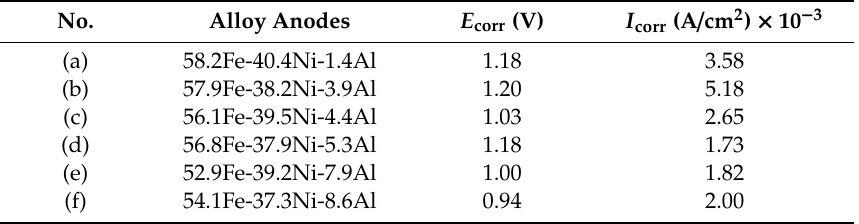
Figure8. Anodicpolarizationcurvesof58.2Fe-40.4Ni-1.4Al( a ),57.9Fe-38.2Ni-3.9Al( b ),56.1Fe-39.5Ni-4.4Al Figure 8. Anodic polarization curves of 58.2Fe-40.4Ni-1.4Al ( a ), 57.9Fe-38.2Ni-3.9Al ( b ), ( c ), 56.8Fe-37.9Ni-5.3Al ( d ), 52.9Fe-39.2Ni-7.9Al ( e ) and 54.1Fe-37.3Ni-8.6Al ( f ) alloys measured in 56.1Fe-39.5Ni-4.4Al ( c ), 56.8Fe-37.9Ni-5.3Al ( d ), 52.9Fe-39.2Ni-7.9Al (e) and 54.1Fe-37.3Ni-8.6Al ( f ) 39.3NaF-43.7AlF 3 -8NaCl-5CaF 2 -4Al 2 O 3 melts at 850 ◦ C (scan rates 0.005 V · s − 1 ; vs. Al / AlF 3 ). alloys measured in 39.3NaF-43.7AlF 3 -8NaCl-5CaF 2 -4Al 2 O 3 melts at 850 °C (scan rates 0.005 V·s − 1 ; vs. Table 4. Corrosion parameters of Fe-Ni-Al alloy anodes measured in 39.3NaF-43.7AlF 3 -8 Al/AlF 3 ). NaCl-5CaF 2 -4Al 2 O 3 melts at 850 ◦ C.